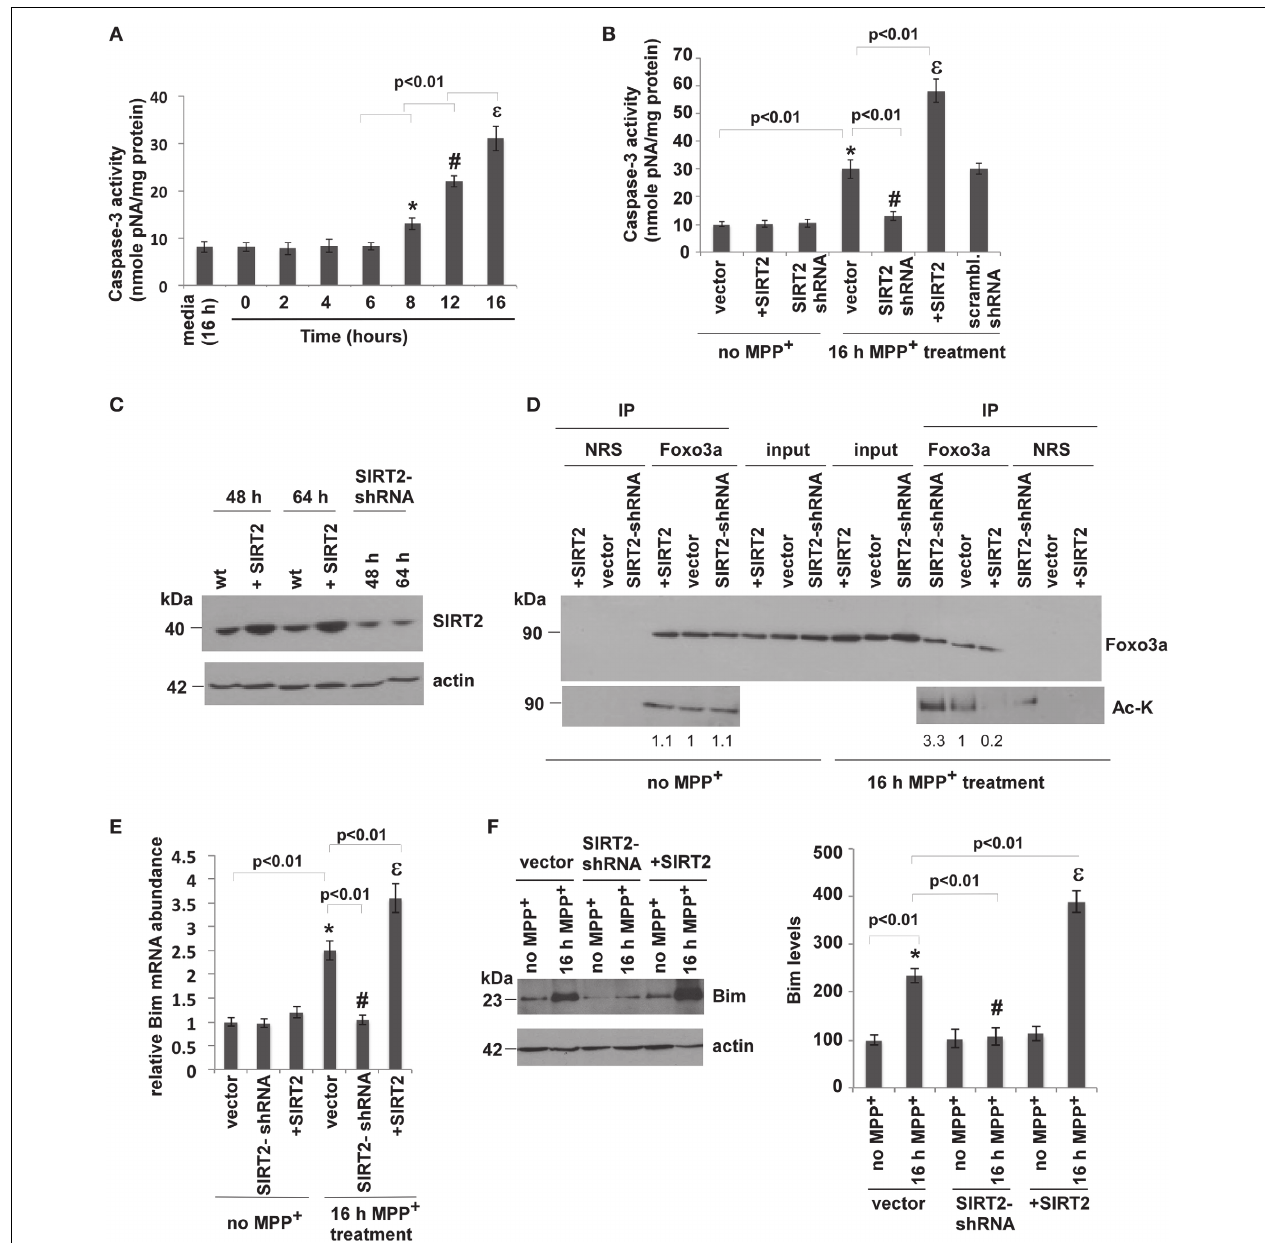
with SIRT2 plasmid and reduced as a result of silencing with SIRT2-shRNA plasmid (total 48h). The expressions were also measured after 64h (48h carried out by densitometry using the NIH ImageJ program and is shown below the gel. (E) Relative Bim RNA levels quantified by qPCR from